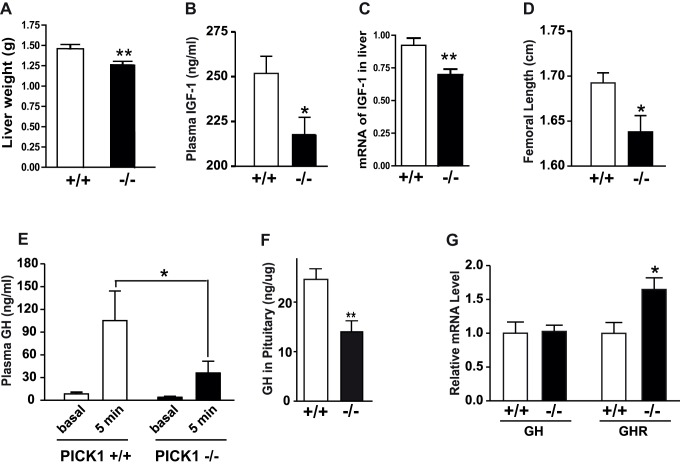
Decreased GH storage and secretion in PICK1-deficient mice.(A) The livers of PICK-1-deficient mice had a significantly lower weight than those of WT mice (**p<0.01). (B) PICK1-deficient mice exhibited a decreased level of plasma IGF-1 (*p<0.05). (C) Decreased relative expression level of IGF-1 mRNA in the liver of PICK1-deficient mice versus WT mice (**p = 0.0045). Measurements in (A), (B), and (C) were performed in samples from 35–38-wk-old WT (+/+) or PICK1-deficient mice (−/−) after overnight fast. Data are means ± SE (n = 10–14). (D) PICK1-deficient mice display reduced femoral length. Measurements were done on 39–41-wk-old WT (+/+) and PICK1-deficient mice (−/−). Data are means ± SE (n = 4–5). *p<0.05, compared to WT. (E) PICK1-deficient mice display decreased ghrelin-induced GH secretion. Basal plasma GH level and the level 5 min after ghrelin administration were determined in anesthetized WT (+/+) and PICK1-deficient mice (−/−) at the age of 7–9 wk. White bars, WT (+/+); black bars, PICK1-deficient mice (−/−). Data are means ± SE (n = 7–9). *p<0.05, compared to WT. (F) PICK1-deficient mice display decreased GH content in the pituitary. Pituitaries were taken from 34-wk-old WT (+/+) or PICK1-deficient mice (−/−). Data are means ± SE (n = 4). **p<0.01. (G) Relative expression levels of GH and GHR mRNA in pituitaries, determined by RT-PCR analysis (35–38-wk-old mice). White bars, PICK1 +/+: black bars, PICK1 −/−. Data are means ± SE (n = 7–8). *p<0.05.